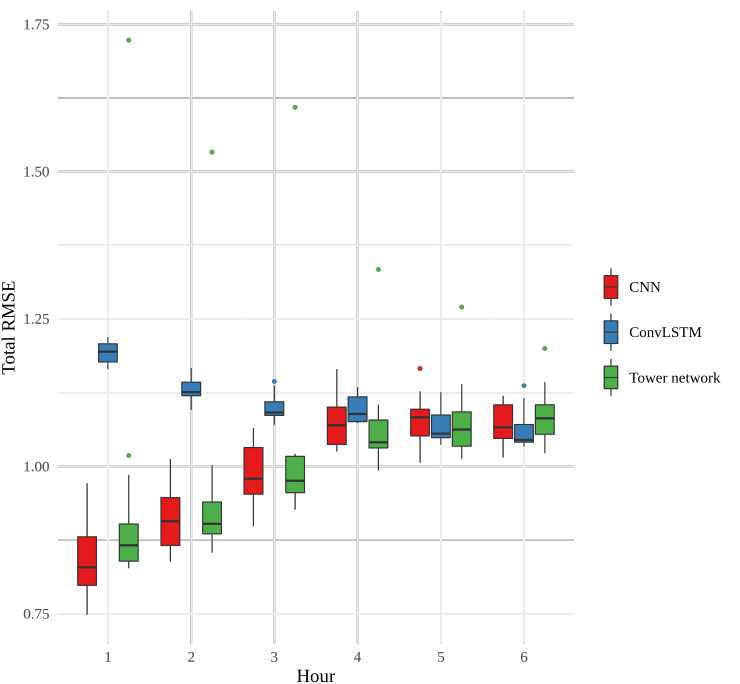
Figure 9. Boxplot showing the root mean squared error of the 15 realizations of each model, averaged over the spatial grid.